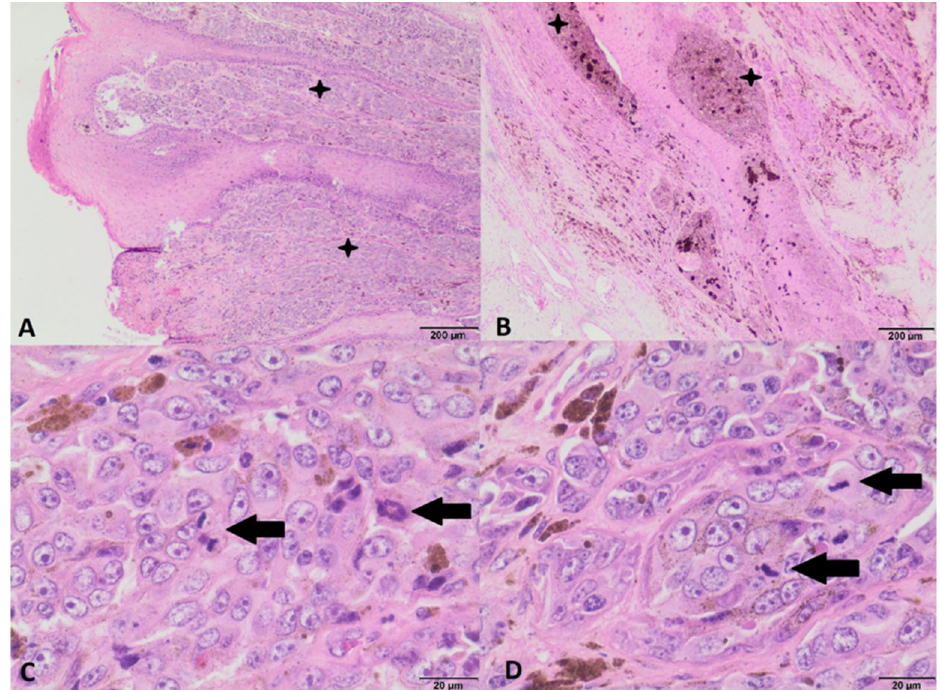
Figure 9. ( A ),( B ): infiltration of neoplastic cells to the dermis (asterisks); HE staining, magn.40×. ( C ),( D ): neoplastic cells with prominent nucleoli, marked anisocytosis and anisokaryosis, and numerous mitotic figures (arrows); dark brown melanin granules are present in the cytoplasm of many neoplastic cells; HE staining, magn. 400×.